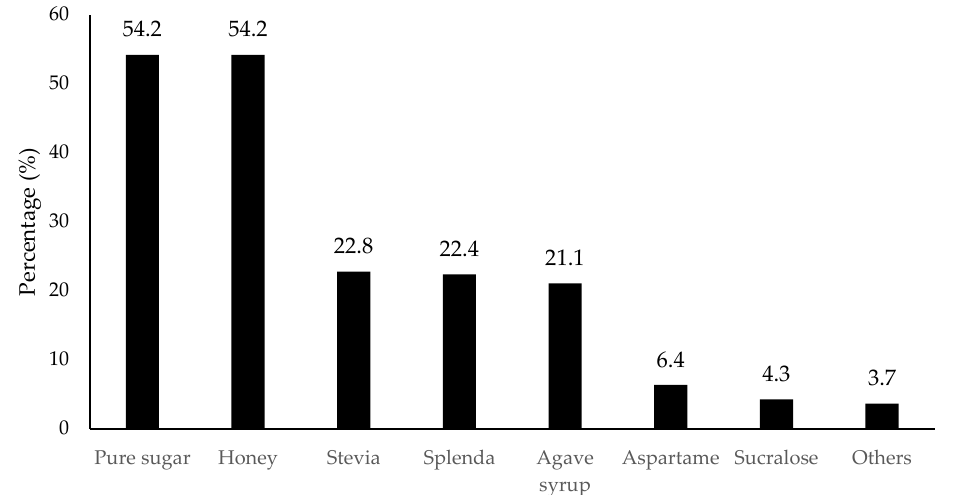
Figure 9. Percentage (%) for the preference of sweeteners ( n = 901). Others included fructose, monk fruit, saccharine, high-fructose corn syrup, maple syrup, dextrose, and fruit juice. 3.5. Impact of Single Demographic Variables—Gender, Age, and Reported Health